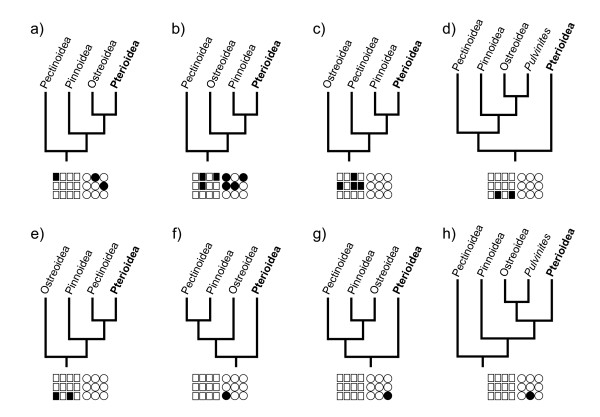
Alternative hypotheses for the pterioidean sister group. Each panel represents a summary topology recovered for the combination(s) of alignment parameters indicated by the sensitivity plots below. See Figure 2 for legend.